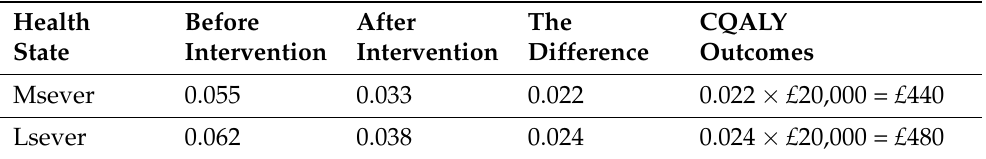
Table 3. The change in QALY outcomes due to an intervention taken by the EA. Health